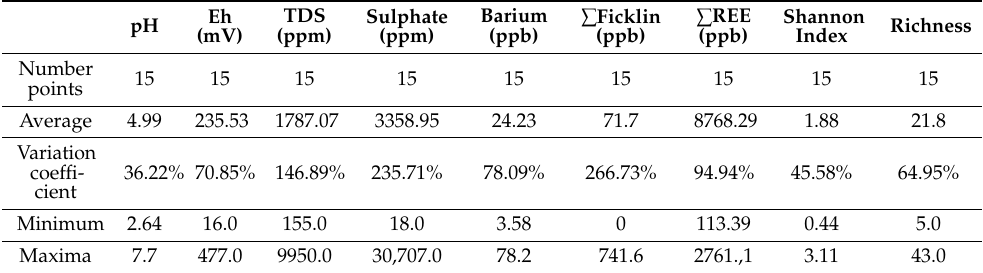
Table 1. Statistical summary of the 9 variables selected in the 15 sampling sites. TDS Barium Sulphate pH Eh (ppm) (mV) (ppm)